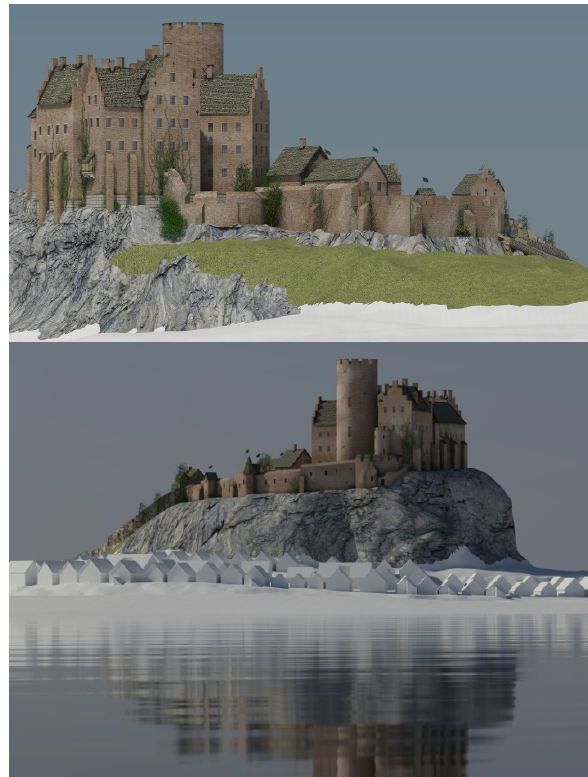
Figure 13. Two perspective views of the Siegesburg on top of the Kalkberg rendered with 3ds